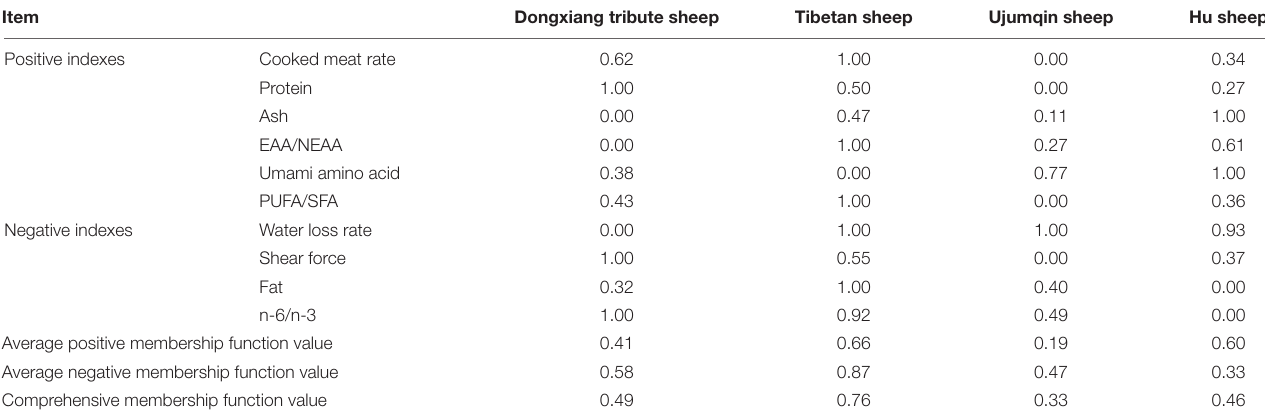
TABLE 1 | Membership function values of mutton quality index in four sheep